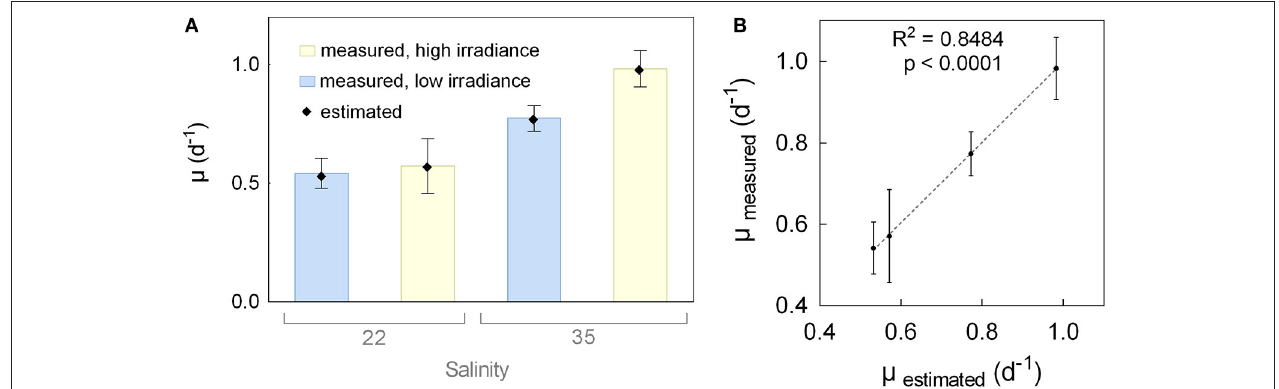
FIGURE 1 | Growth rates ( µ ) during pre-cultivation. (A) Average growth rates of repeated dilutions (bars, n = 7) and estimated growth rates by the model (dots) of the diatom Attheya septentrionalis grown at four different cultivation conditions (combinations of low or high salinity [22 and 35] and irradiance [50 and 200 µ mol photons